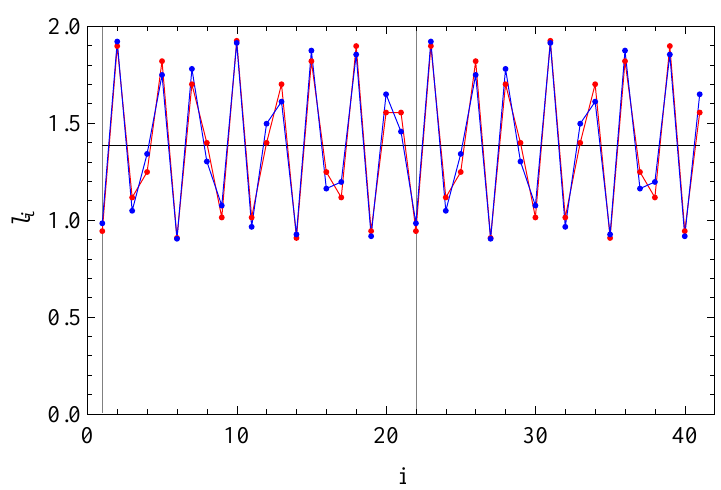
Figure 4: Example of two degenerate CDW ground states: the bond lengths ℓ cording to Eq. (99) with φ = 0 and φ = 0.03. The period is N = 21 sites and 2 unit-cells are shown with a density of electron pairs c = 8 / 21, ¯ a = 0.25, q = 0.1. The small zero energy deformation between the two curves is the phason